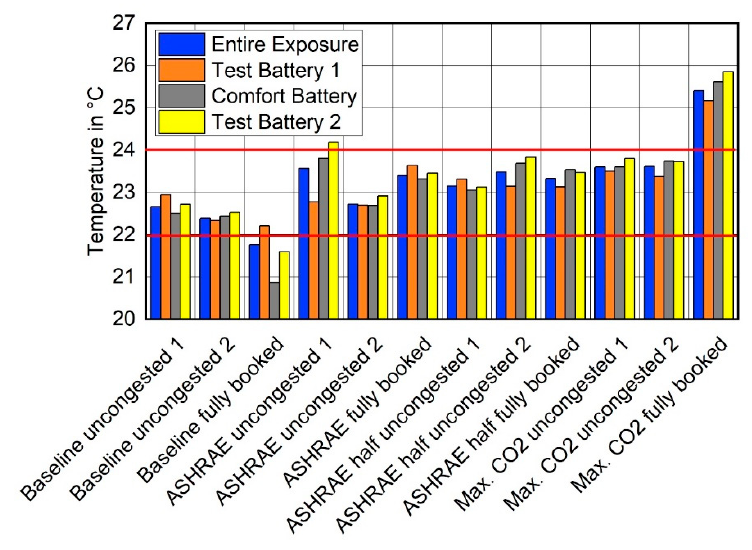
Figure 8. Average cabin